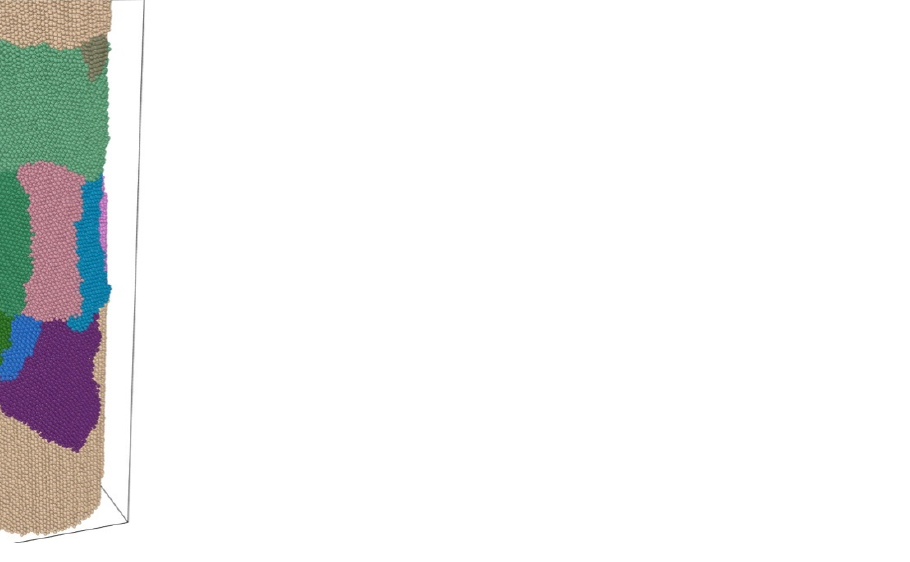
Figure 7. The grain structure (2100 K) resulting from the crystallization of the 10 nm diameter MG nanorod. Colors indicate different grain orientations.